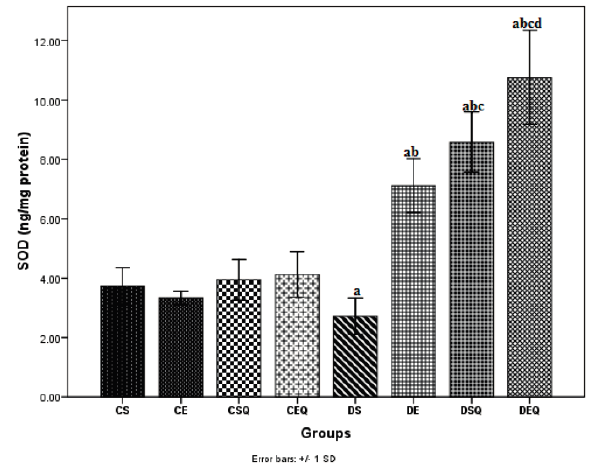
Figure 3. The effects of quercetin and moderate exercise training on the level of superoxide dismutase (SOD) (ng/mg protein) activity in the thoracic aortic tissue homogenates of control and diabetic rats. Results are the means ± SD for ten animals each group, defined as in the caption of Figure 1. Statistically significant differences are indicated by the symbols: a p < 0.05 vs. CS group, b p < 0.05 vs. DS group, c p < 0.05 vs. DE group and d p < 0.05 vs. DSQ